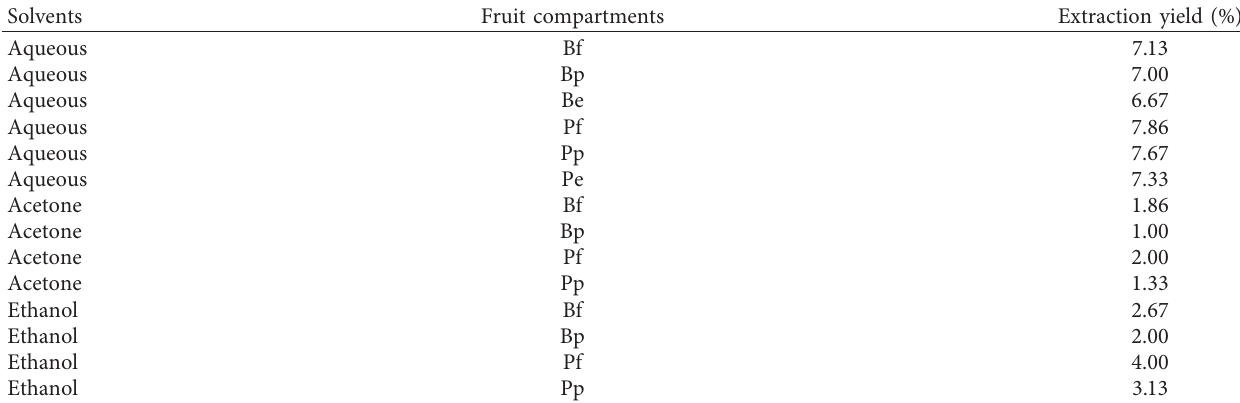
Table 1: Extraction yield of solvents.